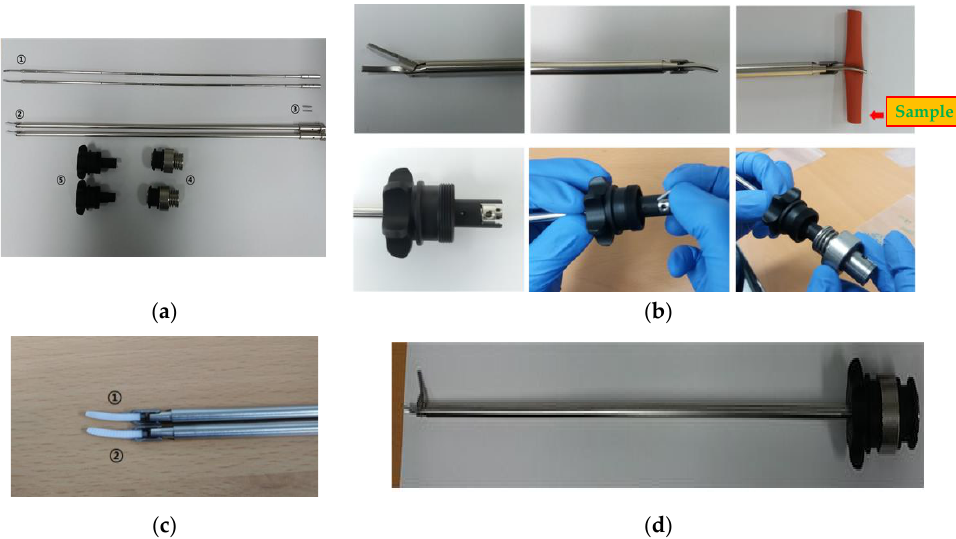
Figure 4. ( a ) Waveguide components; ( b ) assembly of waveguide component; ( c ) jaw pad; ( d ) prototype of the waveguide.